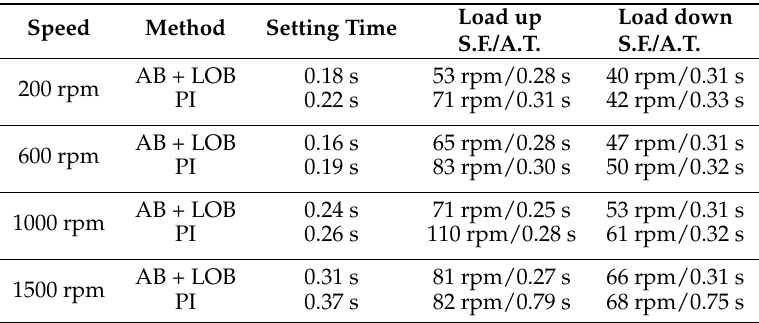
Table 2. The detailed data comparison of Case 1.